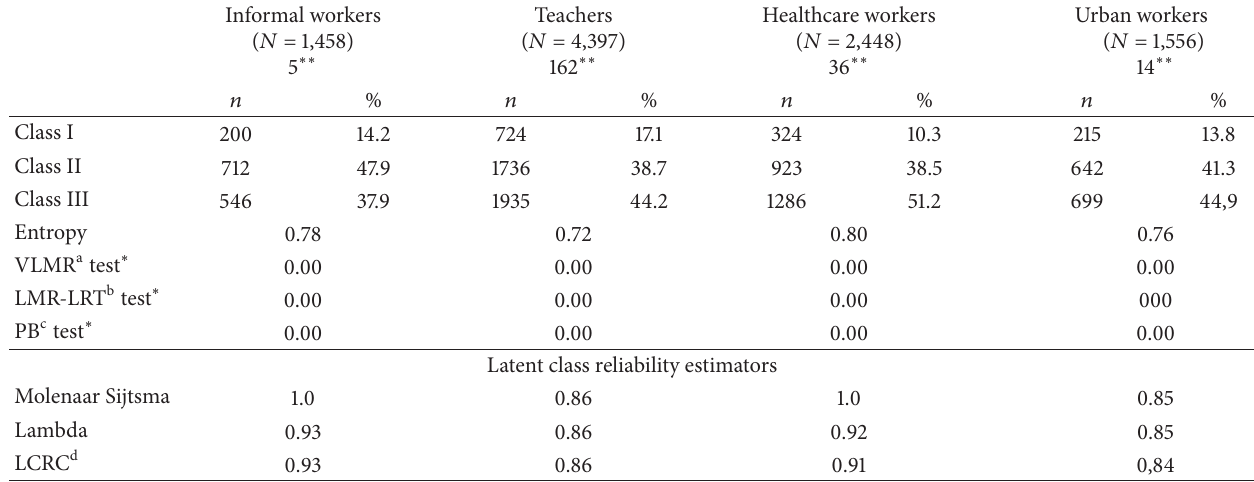
Table 2: Summary of the latent class analysis in four professional